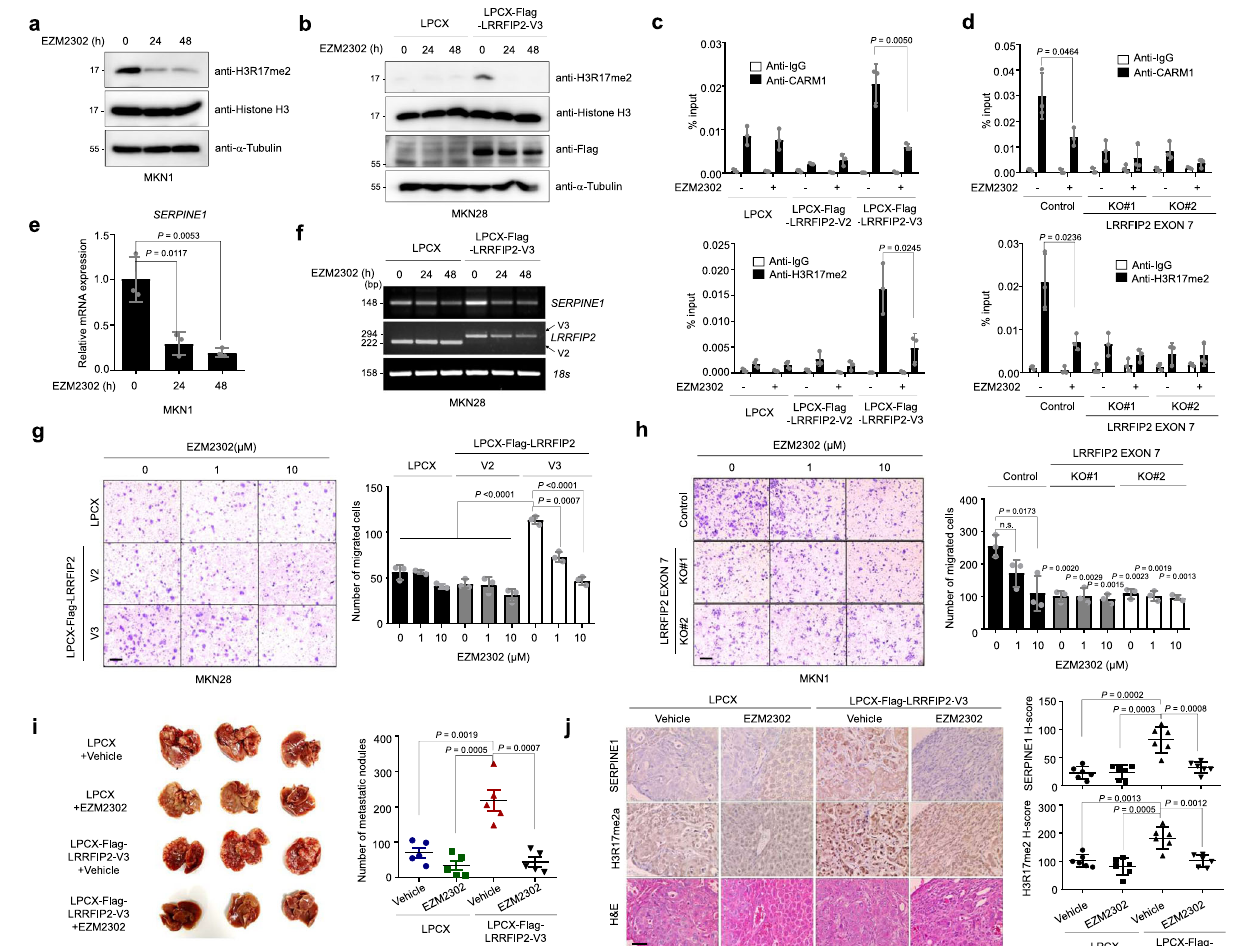
Fig. 6 | EZM2302 reduces metastatic potential of gastric cancer cells by attenuating SERPINE1 expression in the presence of LRRFIP2 variant 3. a Immunoblot analysis showing expression of H3R17me2a and histone H3 in MKN1 cells upon EZM2302 treatment for indicated hours. b Immunoblot analysis showing expression of H3R17me2a, histone H3, and Flag in MKN28 cells over- expressing LRRFIP2 variant 3 upon EZM2302 treatment for indicated hours. c , d qChIP analysis of the human SERPINE1 promoter upon treatment of EZM2302 for 24h with antibodies to CARM1, H3R17me2a in c LRRFIP2 variant 2 and 3-overexpressing MKN28 cell lines, d LRRFIP2 variant 3 exon7 deleted MKN1 cell lines. e Real-time qRT-PCR analysis showing SERPINE1 expression in MKN1 cells uponEZM2302treatmentforindicated hours. f RT-PCRanalysis showing SERPINE1 expression in MKN28 cells overexpressing LRRFIP2 variant 3 upon EZM2302 treatmentforindicatedhours. g , h TranswellmigrationassayandMatrigelinvasion assay of g MKN28 cells overexpressing LRRFIP2 variant 2 and 3 and h LRRFIP2 variant 3 exon 7 deleted MKN1 cells with EZM2302 treatment (left) and bar graphs